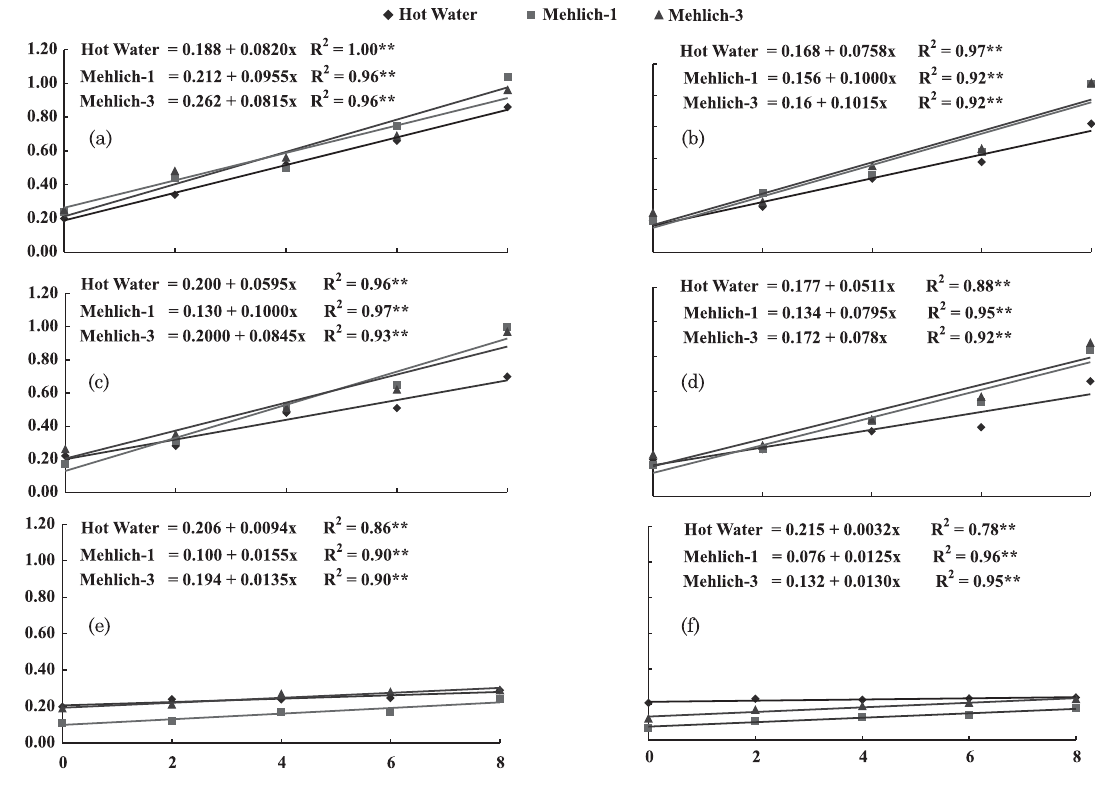
Figure1. Boron concentration in soil according to B rate and Hot Water, Mehlich-1 and Mehlich-3 extractors in the depths: (a) 0–0.05 m; (b) 0.05–0.10 m; (c) 0.10–0.15 m; (d) 0.15–0.20 m; (e) 0.20–0.30 m; (f) 0.30–0.40 m in eutropherric Red Latosol (Rhodic